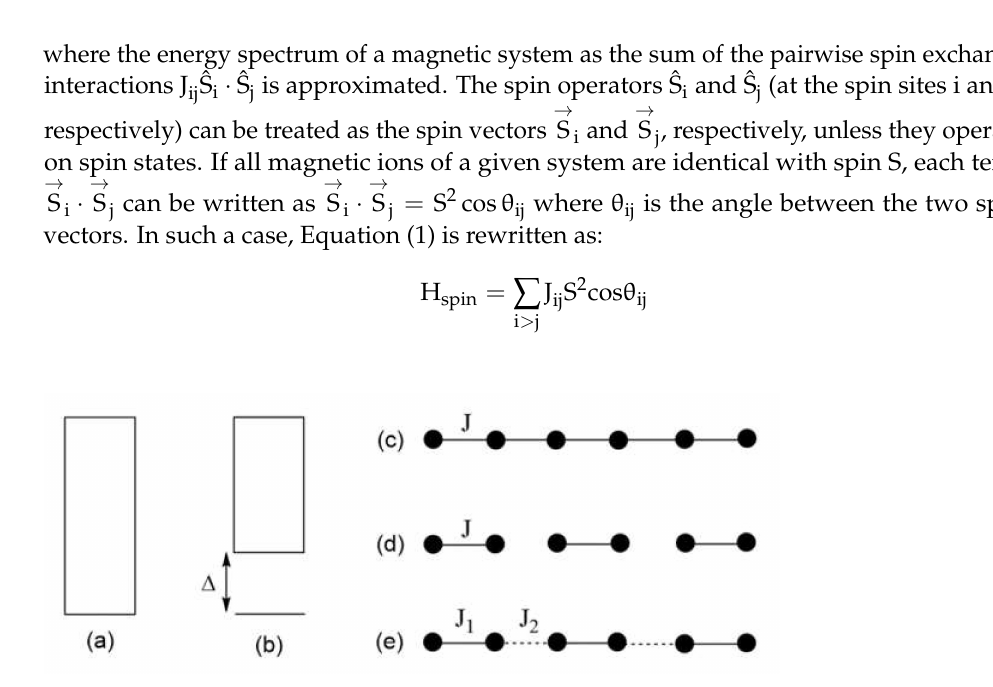
Figure 1. ( a , b ) Allowed energy states of a magnetic solid. Between the lowest-lying excited state and the ground state, there is no energy gap in ( a ), but a non-zero energy gap in ( b ). ( c – e ) Examples of simple spin lattices: a uniform chain in ( c ); isolated spin dimers in ( d ); and an alternating chain in ( e ). Here, all nearest-neighbor spins are antiferromagnetically